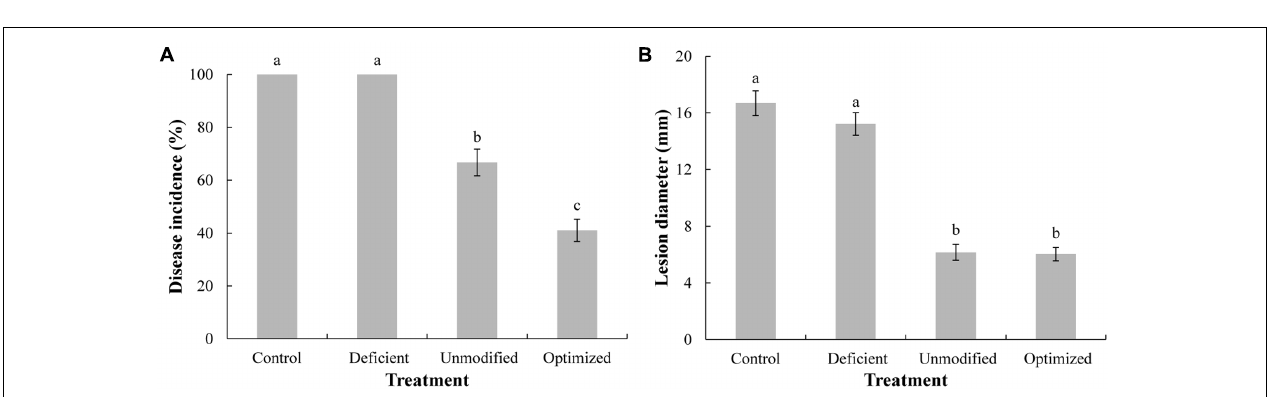
FIGURE 4 | GPX (A) and SOD (B) enzyme activity in yeast cells of C. diversa after 96-h culture in three different media: unmodified MM medium, ion-deficient MM medium, and Mg 2 + , Fe 2 + , and Zn 2 + optimized MM medium. Data represent the mean ± SD of the pooled data from three experiments ( n = 9). Columns with different letters indicate significant differences according to a Duncan’s multiple range test ( P < 0.05).